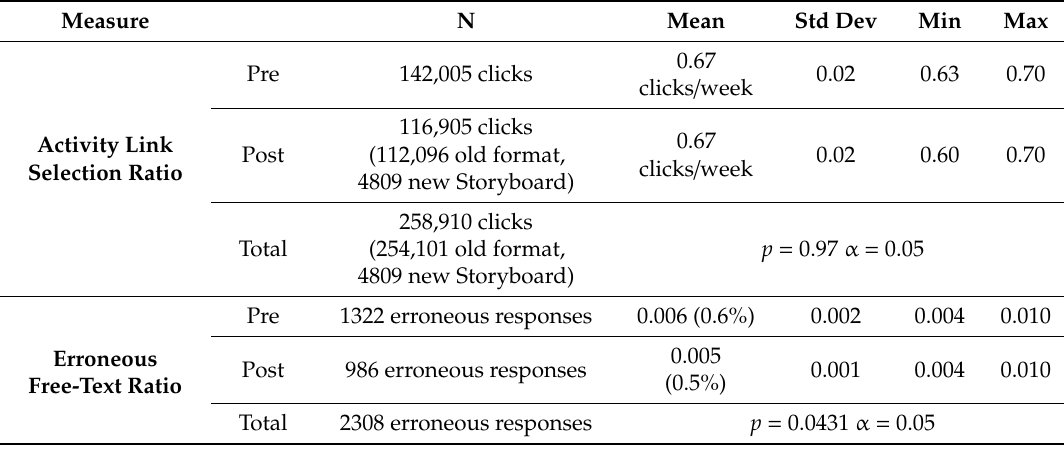
Table 3. Behavior Influence Pre- and Post-Storyboard